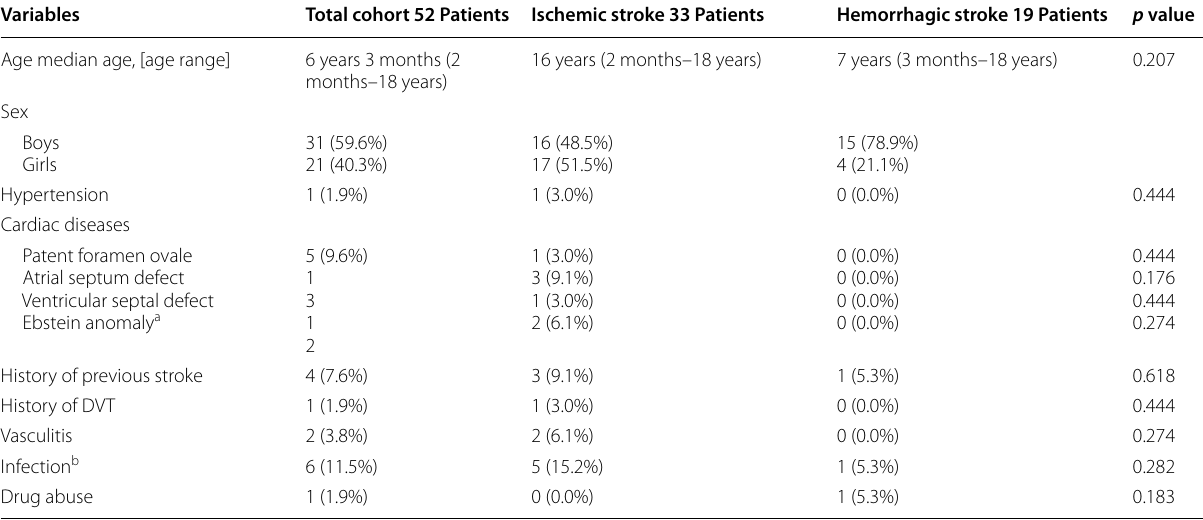
Table 1 Demographic, vascular risk factors, and comparisons between pediatric ischemic and hemorrhagic